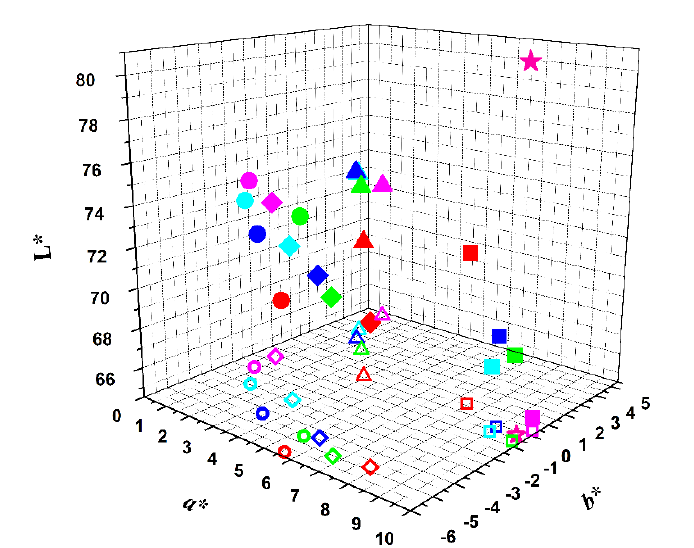
Figure 4. Representation of the colors of the several samples in L*a*b* color scheme, immediately after extract addition (red symbols), and after 1 day (green symbols), 7 days (blue symbols), 14 days (cyan symbols) and 21 days (magenta symbols) of storage at 4  C. Projection in a*,b* plane: open symbols. : red beetroot; : opuntia; : hibiscus; : red radish; : commercial strawberry flavor yogurt. :